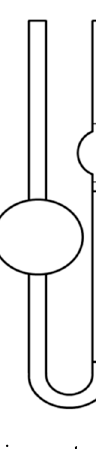
Figure 3. Sketch of an Oswald viscometer showing the upper and the lower marks.